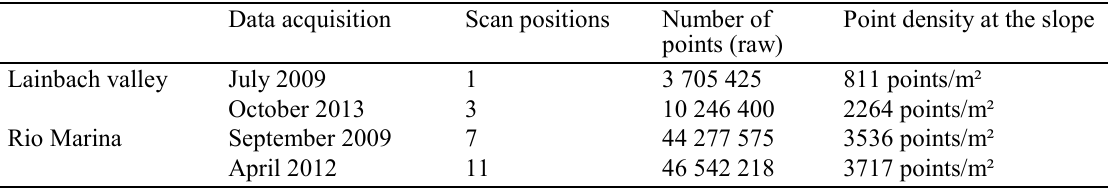
Table 1 Properties of the TLS data Data acquisition Scan positions Number of